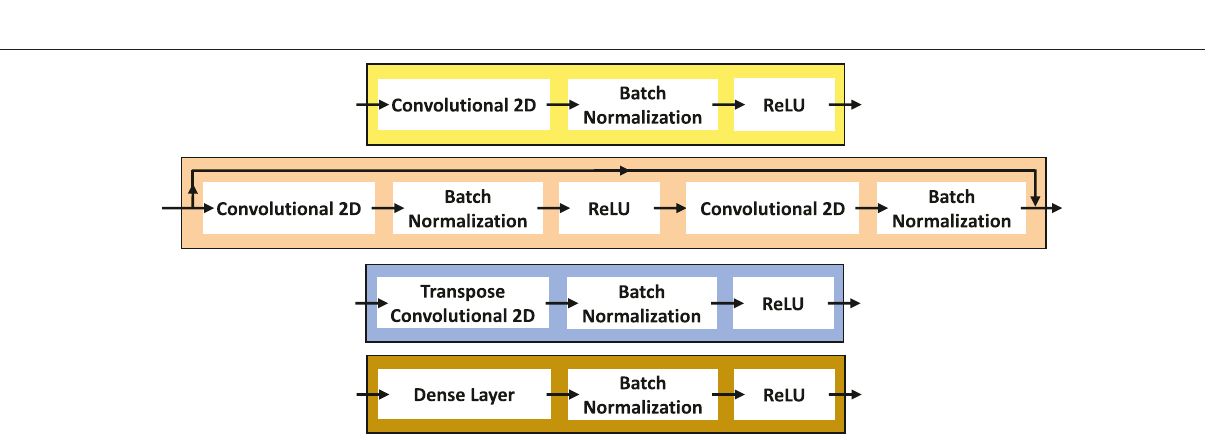
FIGURE 9 | From top to bottom: Encoding block (top) , Residual block, Decoding block, and Transformation block (bottom) (Adapted from [2]).